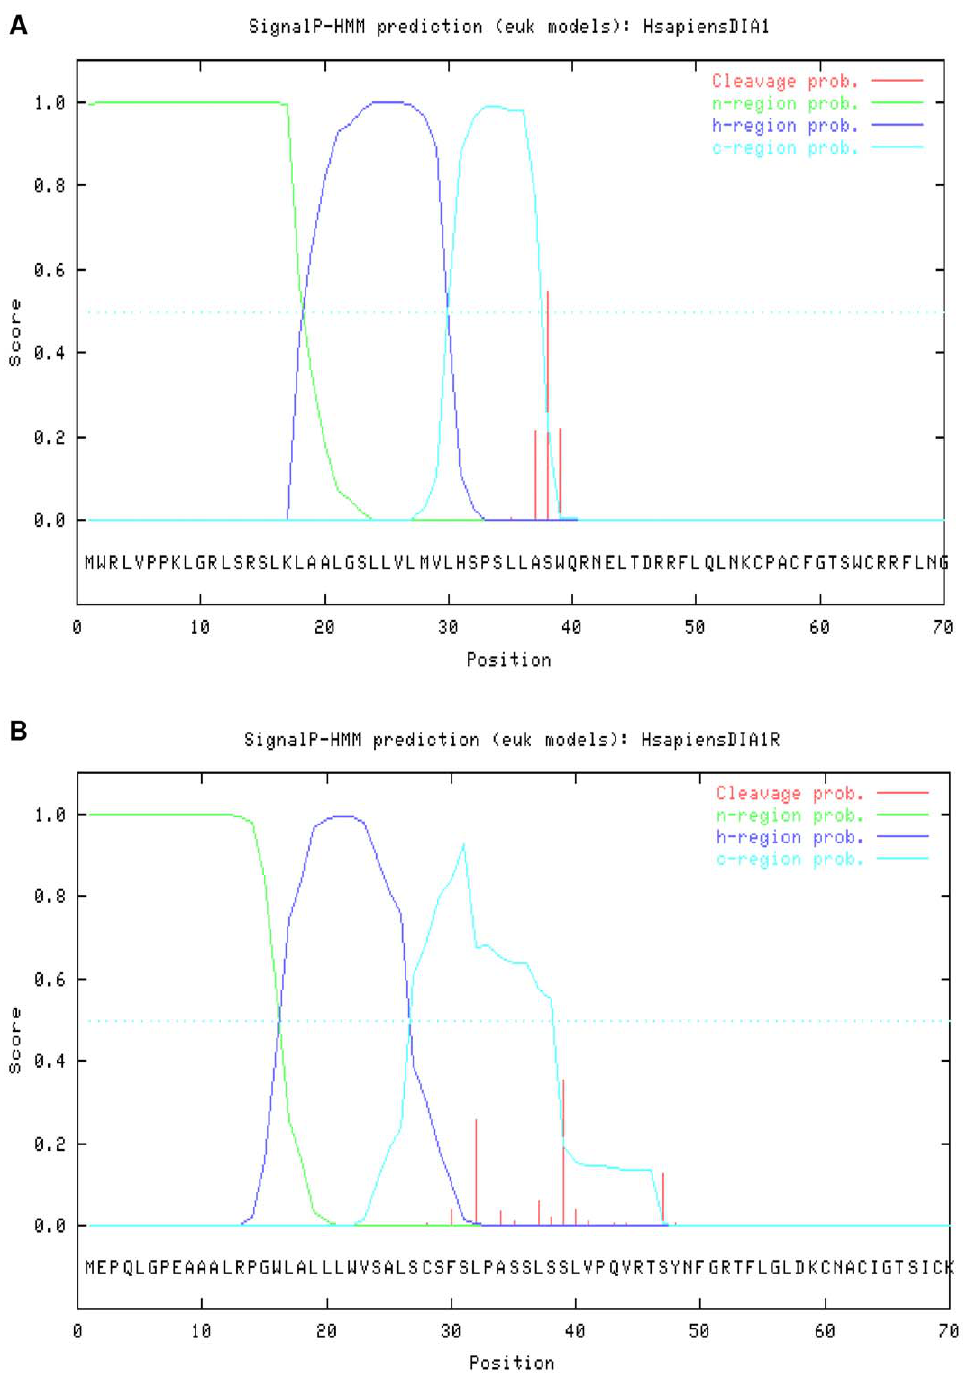
Figure 3. Prediction of signal peptides in human DIA1 and DIA1R. The amino acid sequence of (A) human DIA1 or (B) human DIA1R, was evaluated for amino-terminal signal peptides using the hidden Markov model of SignalP v3.0 [72]. C-region (cleavage-recognition region) scores are in aqua, H-region (hydrophobic region) scores are in dark blue, N-region (N-terminal signal peptide sequence) scores are in green, and the cleavage probability (that a given amino acid is the first in the mature protein) indicated in red. The significance cut-off value for all probability scores is 0.5, and is indicated by a blue dotted line. Standard single-letter amino acid abbreviations and numbering is provided below the graph.